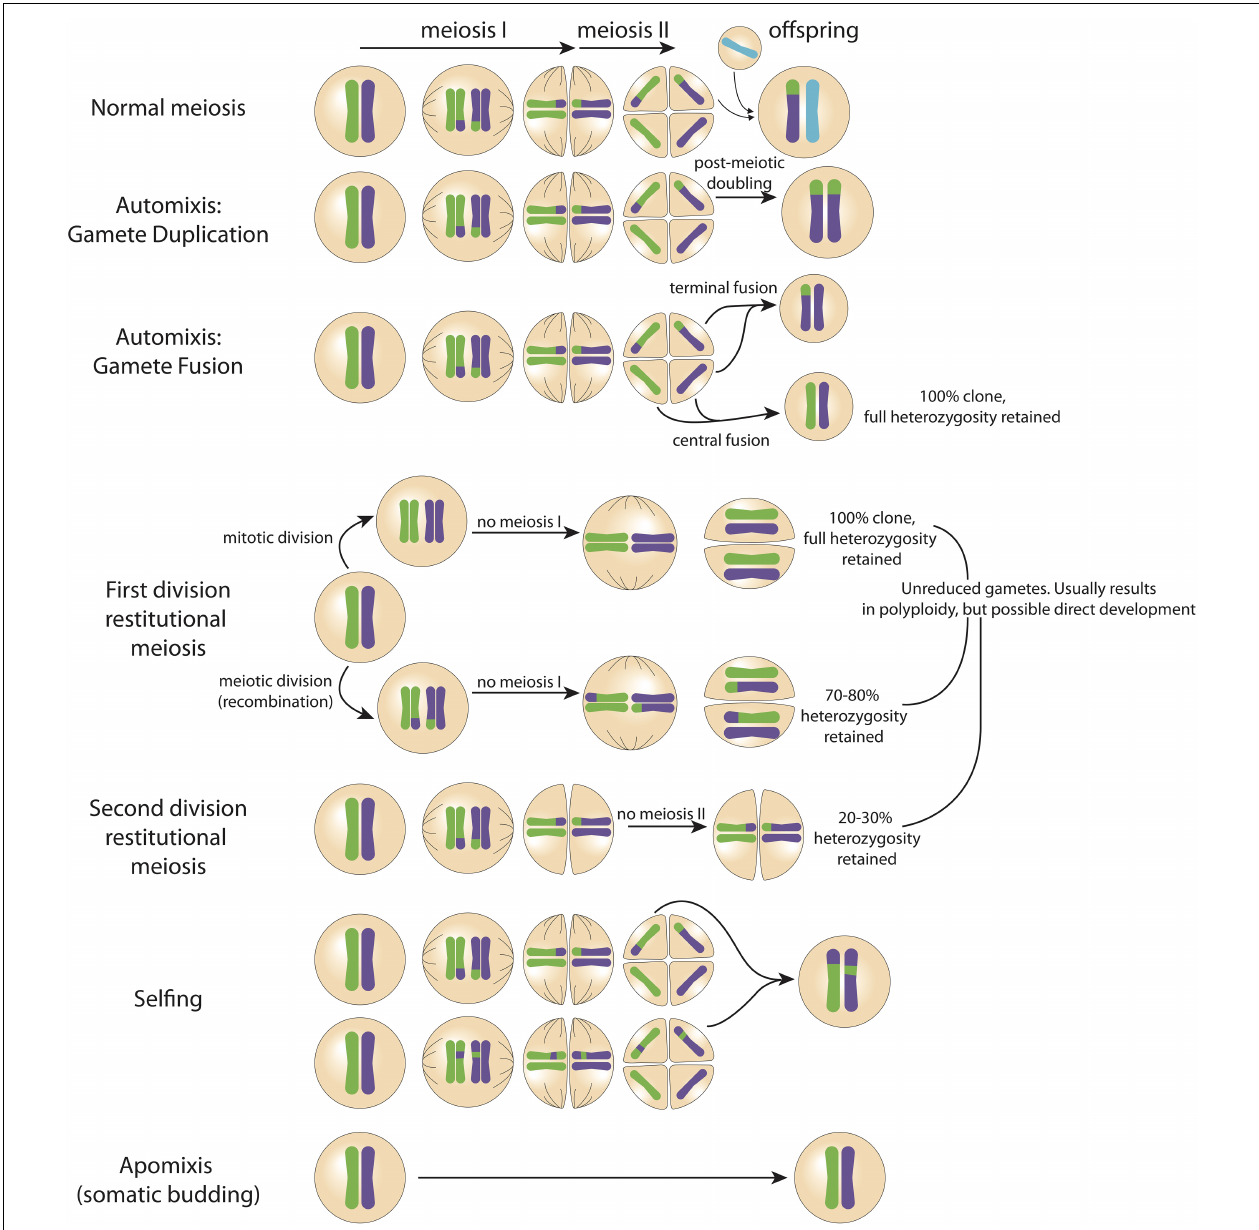
FIGURE 1 | Possible pathways of zygote formation. The genetic material of the parent (in this example heterozygous) is represented by the green and purple chromosomes in the far left cell. Changes in the relative proportion of genetic material being passed to the offspring can occur throughout germ cell creation (i.e., meiosis I and meiosis II). In normal sexual reproduction, half the genetic diversity of the parent is transmitted to the offspring. Full clones with 100% of heterozygosity retained can form via central fusion (automixis), first division restitutional meiosis, and apomixis (somatic budding). Importantly, previous studies have not used genetic markers at a resolution sufficient to accurately detect fully clonal